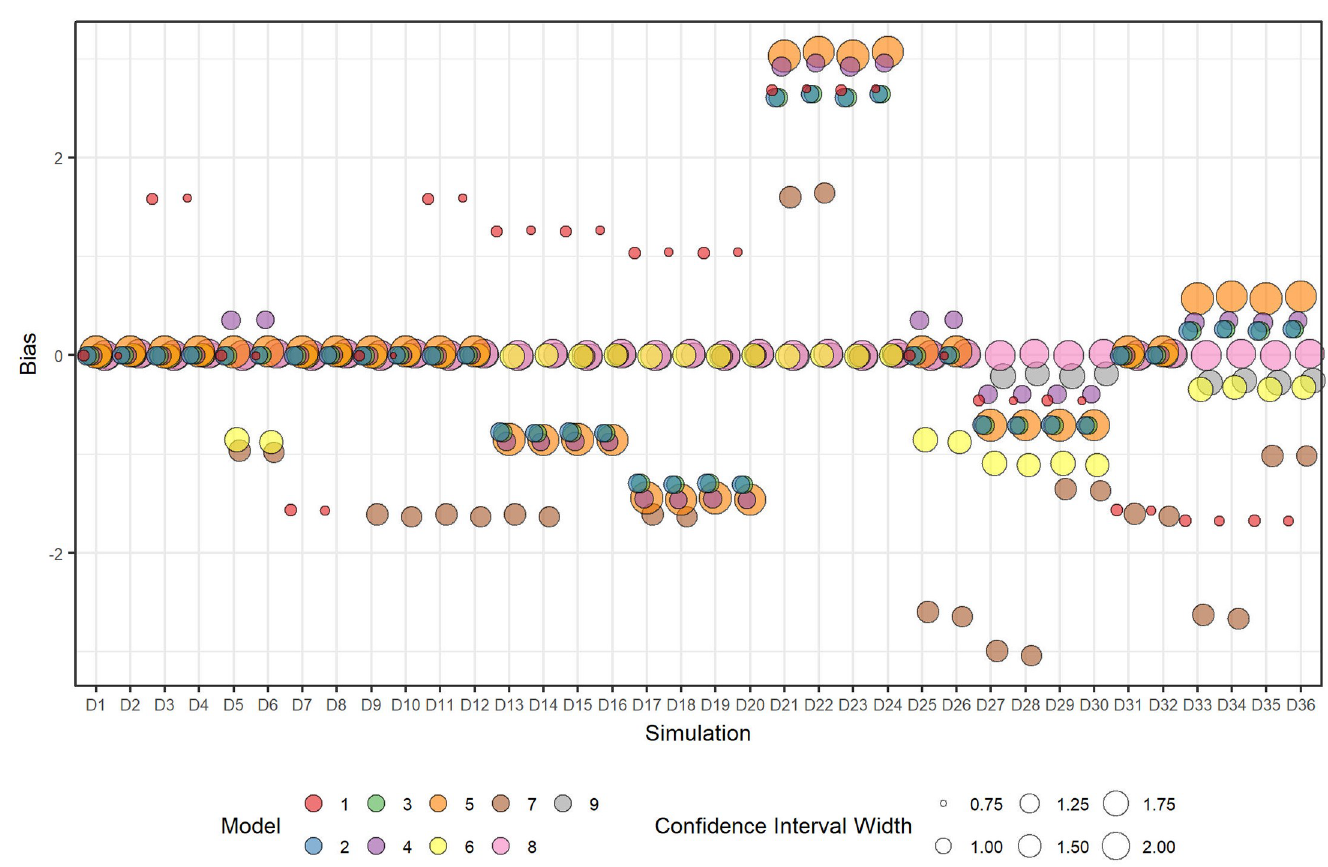
Fig 6. Plot of mean bias and mean 95% confidence interval width over all datasets within each scenario for each fitted model for the estimate of the intervention effect at six months exposure.